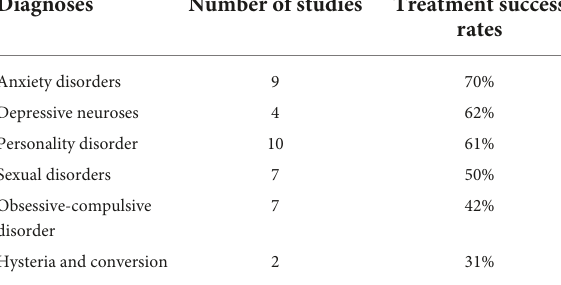
TABLE 5 Treatment results for different groups of treatment-resistant patients with psycholytic therapy